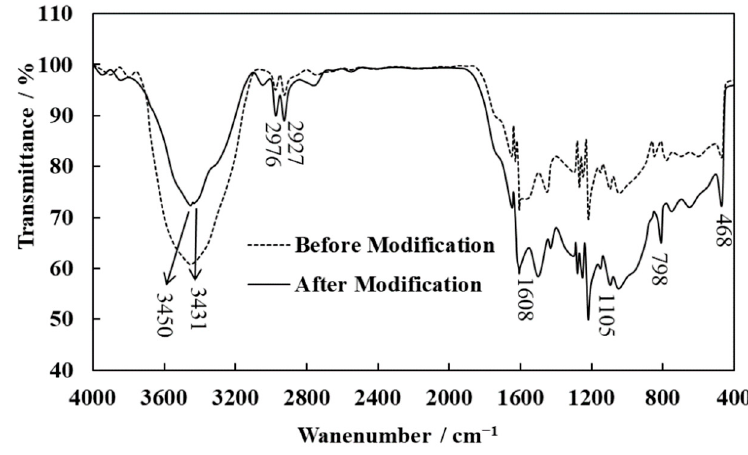
Figure 11. FT-IR spectra of N-WPCBs and N-WPCBs modified by KH-550.